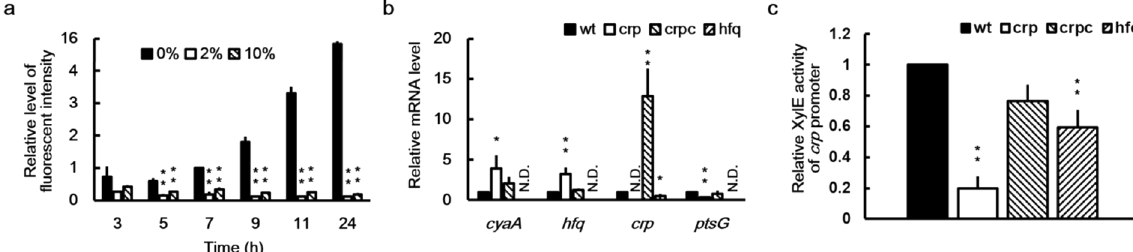
Figure 1. Crp activity was inhibited by high glucose levels; cyaA , hfq , ptsG , and crp itself were regulated by Crp, and crp was regulated by Hfq in P . mirabilis . ( a ) Crp activity increased in the absence of glucose and decreased by 2% and 10% (2000 and 10,000 mg/dL) glucose. The plac-gfpuv reporter plasmid-transformed wild-type P . mirabilis was grown in LB broth with or without glucose, and the fluorescent intensity of GFPuv was monitored after incubation for 3, 5, 7, 9, 11, and 24 h. The fluorescent intensity in the absence of glucose at 7 h was set at 1, and all other data are expressed relative to this value after being normalized against the OD 600 value. The data are the averages and standard deviations of three independent experiments. The significant difference between the presence and absence of glucose at each time point was determined using the Student’s t test ( ** P < 0.01). ( b ) Crp regulated the expression of cyaA , hfq , and ptsG mRNA, and crp expression was regulated by Hfq in P . mirabilis . Overnight bacterial cultures were diluted in LB broth and incubated for 7 h before total RNA was prepared for measuring mRNA levels of cyaA , hfq , crp , and ptsG in the wild-type strain, crp mutant, crp - complemented strain, or hfq mutant by using real-time RT-PCR. The mRNA level for the wild-type strain was set at 1, and all other data are expressed relative to this value. N.D., not determined. ( c ) crp promoter activities of wild-type P . mirabilis , crp mutant, crp -complemented strain, and hfq mutant. The activities of XylE in the crp-xylE reporter plasmid-transformed P . mirabilis strains were determined using the reporter assay at 7 h after incubation. The value obtained for the wild-type strain was set at 1. In ( b ) and ( c ), the data are the averages and standard deviations of three independent experiments. Significant difference from the wild-type strain is indicated with an asterisk ( * P < 0.05; ** P < 0.01 by using Student’s t test). wt, wild-type; crp, crp mutant; crpc, crp -complemented strain; hfq, hfq